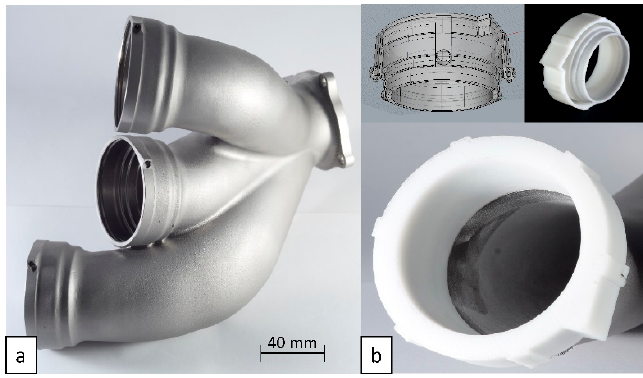
Figure 15. Inconel718 automotive exhaust manifold ( a ) and covers used to shield machined zones ( b ).